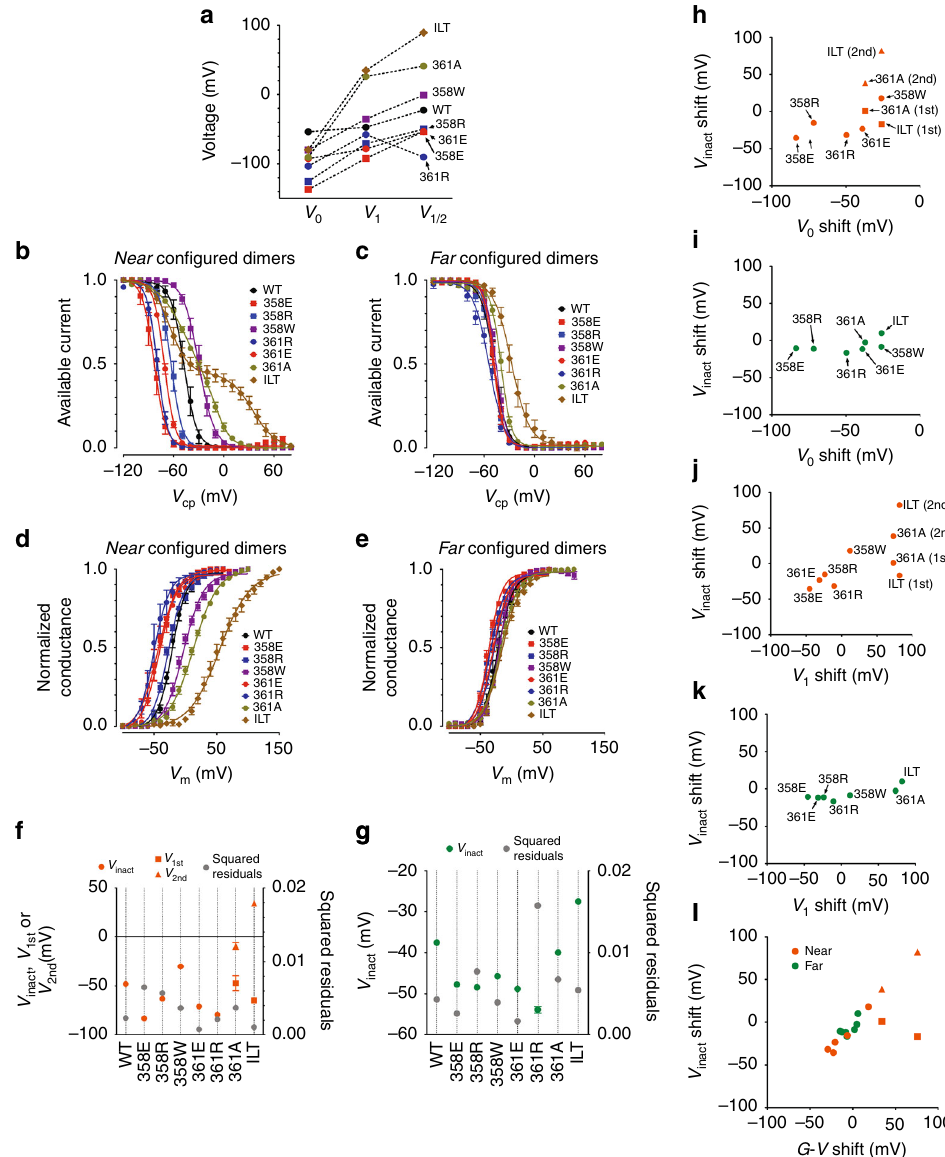
Fig. 4 Study of the VSD mut //PD W434F interfaces in W434F-Shaker dimers. a Voltage dependences of Shaker containing different VSD mut . Plots show three voltage dependences of Shaker channels with different VSDs: V 0 and V 1 from Q – V and V 1/2 from G – V curves. b , c Inact- V curves from W434F-Shaker dimers, near and far con fi guration, respectively and as indicated, for each VSD mut case. Mutations in the VSD are color/shape coded and are shown in the insets. d , e G – V curves for the same channels, near and far, shown in b and c with the mutations indicated by same color/shape code as in b and c . All Inact- V curves, except from near dimers containing VSD 361A or VSD ILT , were fi tted by a two-state model: noninactivated and inactivated (see “ methods ” section for details), generating a voltage-dependent parameter V inact (Supplementary Tables 1 and 2). In near dimers containing VSD 361A or VSD ILT , the curves were fi tted by two independent two-state models to generate two voltage-dependent parameters: V 1st and V 2nd . f , g Plots of V inact , V 1st , and V 2nd from near and far different dimers as labeled, respectively. Squared residuals from the fi ttings that generated the voltage-dependent parameters V inact , V 1st , and V 2nd are also plotted and connected to them by the vertical dotted lines. Shifts in V inact (or V 1st and V 2nd ) from near (orange circles for V inact , squares for V 1st and triangles for V 2nd , h and j ) and far dimers (green circles, i and k ) relative to the values in the respective Shaker dimers with VSD wt only plotted against the respective shifts in V 0 ( h and i ) and V 1 ( h and i ) from VSD mut taken from Q – V curves in nonconductive Shaker. l The same shift values of V inact , V V – k from near and far dimers were plotted against the shifts in V mut (also relative to 1st and 2nd shown in h 1/2 in Shaker induced by the respective VSD channels with VSD wt only). Labels at each data point were omitted for clarity. All data points are the average of 4 – 6 independent experiments. The vertical bars in b – g are the standard error of the mean. The error bars in plots h – l were omitted for